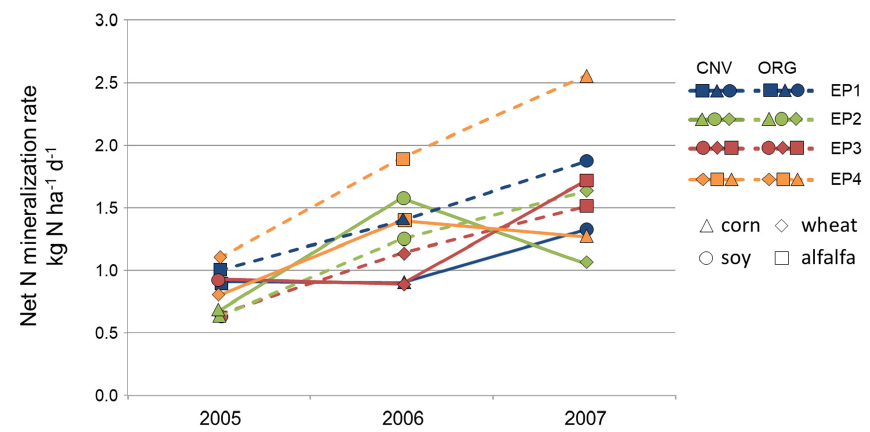
Figure 5. Change in net N mineralization rate (kg ha − 1 d − 1 ) by system and entry point over three growing seasons. Within years net N mineralization rate was obtained by linear regression on the cumulative amount of mineralized N measured over successive incubation periods. The Nmin rates in ORG-EP4 was 30% to 40% greater than the overall ORG average. This was